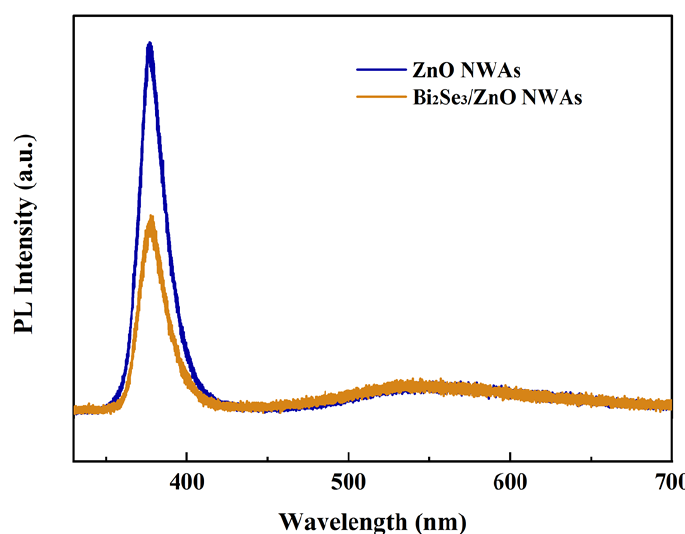
Figure 3. Photoluminescence (PL) spectra of ZnO NWAs and Bi 2 Se 3 /ZnO NWAs. To assess the photoresponse performance of Bi 2 Se 3 /ZnO NWAs heterojunction, Pt in- Figure 1. Responsivity performance is measured as shown in Figure 4. The spectral re-